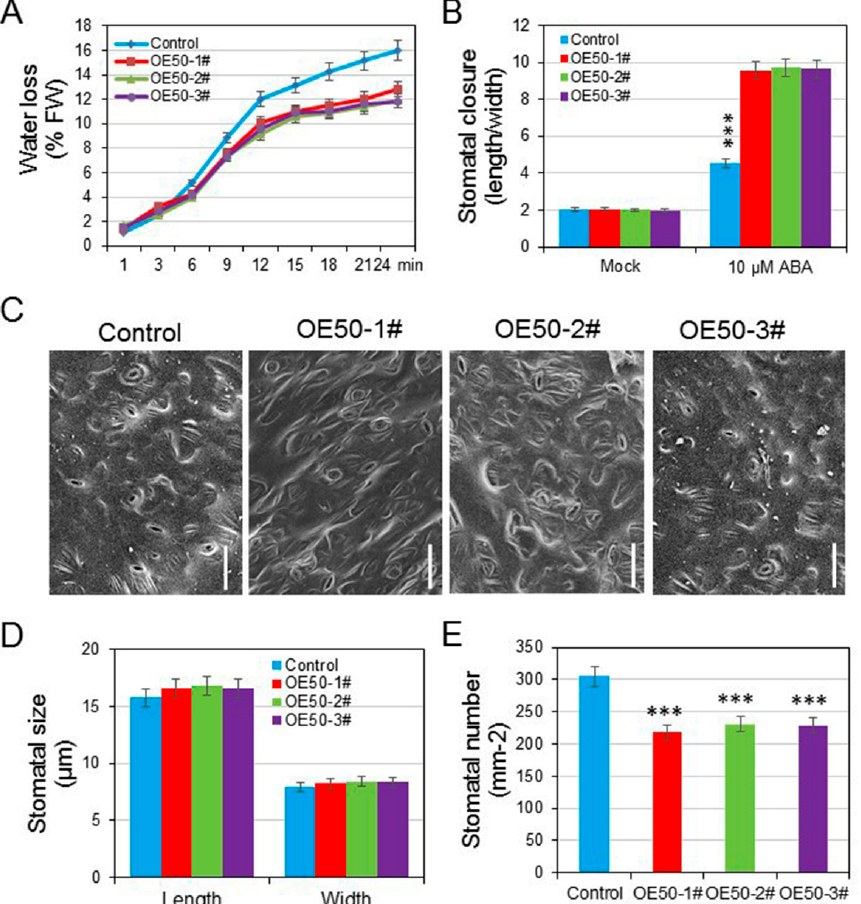
Figure 6. HcWRKY50 promoted ABA-induced stomatal closure and decreased the stomatal density. ( A ) Water loss from 0.5 g detached leaves of the HcWRKY50 transgenic (OE50-1#, OE50-2#, and OE50-3#) and control lines. Three replicates were repeated at each time point. ( B ) The stomatal length/width ratio was used to evaluate stomatal closure. ( C , D , E ) Stomatal size and stomatal density ( D , E ) were photographed ( C ) and compared between the control and HcWRKY50 transgenic lines. Values represent the means ( ± SD) from three independent replicates. Significant differences are represented by asterisks corresponding to *** p < 0.01 by ANOVA